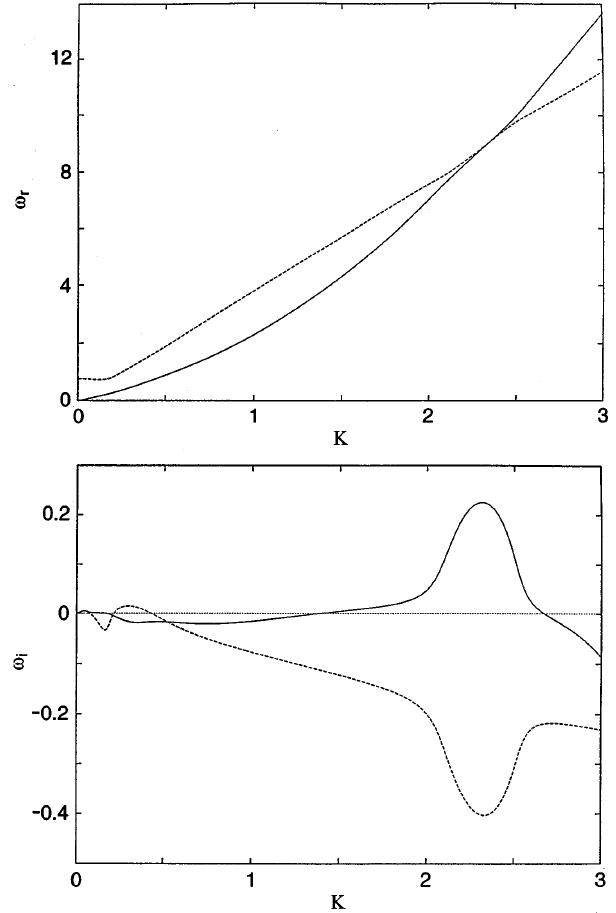
Fig. 2. Real and imaginary parallel dispersion of the reference magnetoplasma (unstable modes) when the unperturbed gyrophases of the protons and alpha particles are monochromatic. Normaliza- tions as in